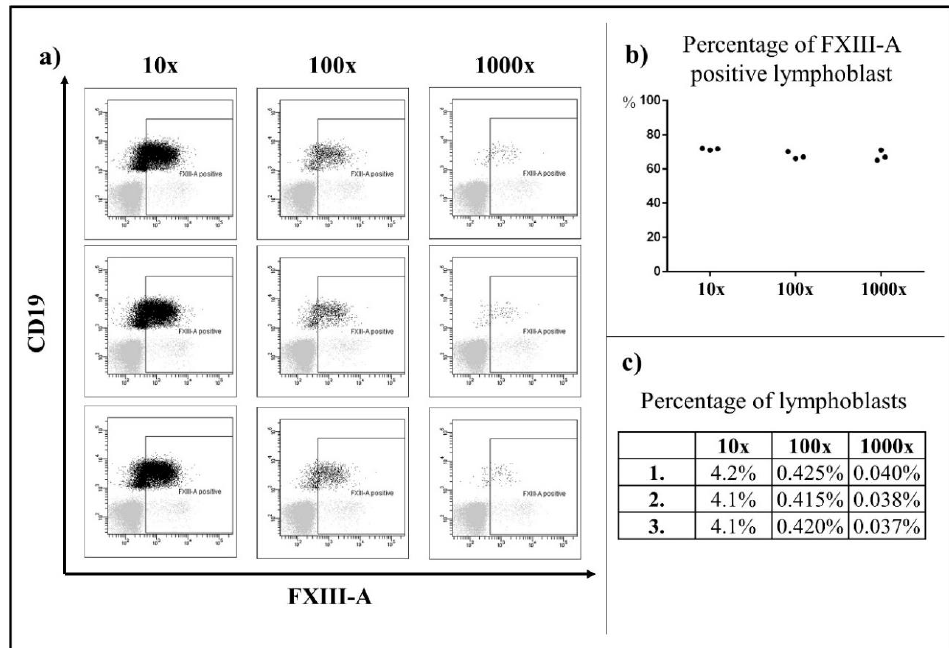
Figure 4. Detection of FXIII-A expression on analysis of serial dilutions. Based on a three parallel serial dilutions (10×; 100×; 1000×), the percentage of FXIII-A expression in residual lymphoblasts could be clearly assessed when the percentage of lymphoblasts was above 0.04%. Black color indicates the residual lymphoblasts, grey color represents the mature lymphocytes, which were the negative control. ( a ) The percentages of FXIII-A positive lymphoblasts within all lymphoblasts were similar in the three parallel staining instances ( b ) The percentages of lymphoblasts served as the internal control of the serial dilutions ( c ).